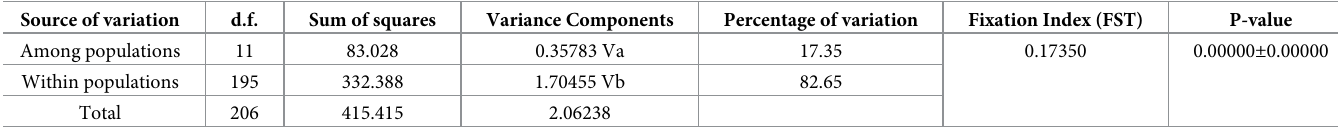
Table 4. AMOVA analysis of I2 cattle of Andaman and different regions of Indian subcontinent and Island Southeast Asian countries. Source of